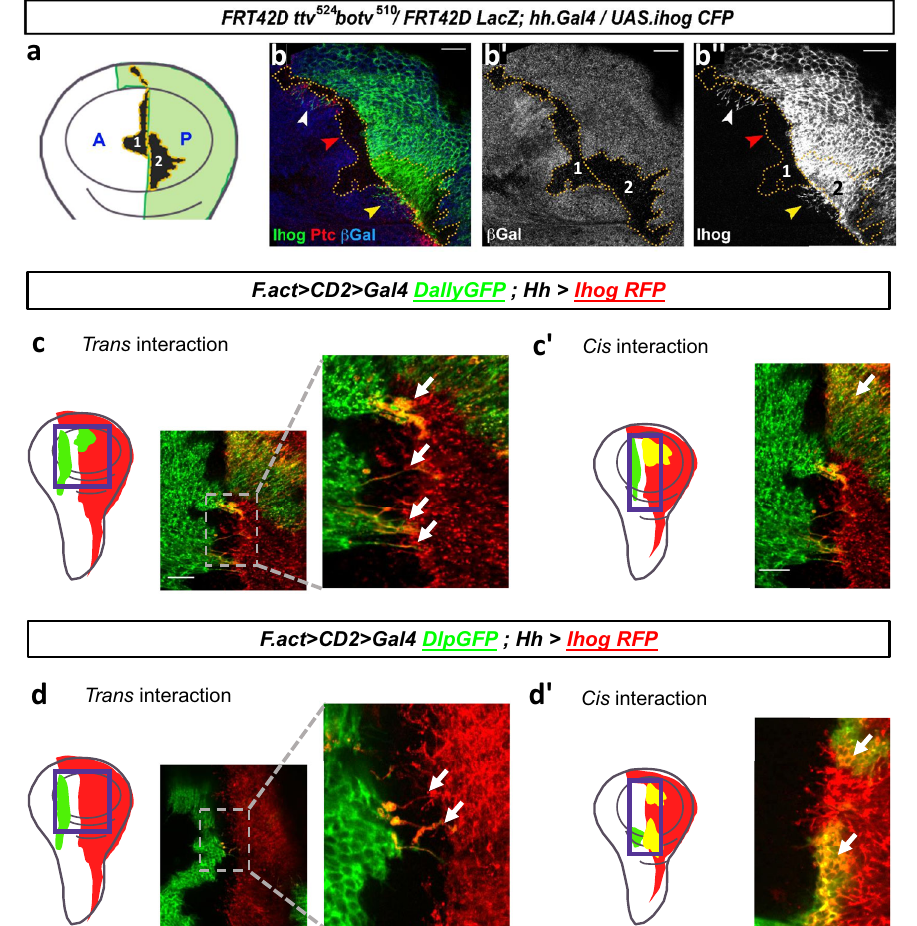
Fig. 3 | Cytoneme behavior depends on Ihog and glypicans levels. a Scheme depicting induced ttv -/- botv -/- doublemutant clones in a wing disc whileexpressing also Ihog inthe P compartment(green). b Wing disc containing induced ttv -/- botv -/- double mutant clones marked by the absence of β gal ( b ’ ) while expressing Ihog in the P compartment ( b ” ). Cytonemesstabilizationcan beobserved (white arrow) in A compartment cells except in glypicans loss of function clones induced in the A compartment cells, which do not express Ihog (red arrows). The yellow arrow indicatesthe presenceof stabilized cytonemes when the ttv -/- botv -/- doublemutant cloneisoriginatedinthePcompartment,whichoverexpressesIhog,indicatingthat glypicans arerequired in trans and not in cis for cytoneme stabilization. c Ihog and